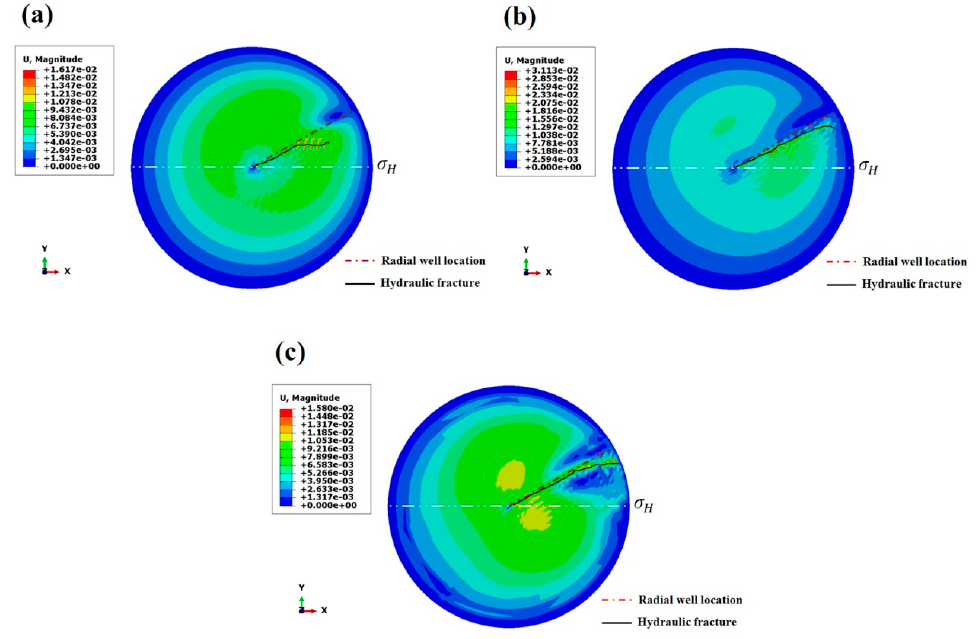
Figure 8. Simulation results of hydraulic fracture propagation guided by a single radial well under radial well different diameters: ( a ) Φ = 0.03 m; ( b ) Φ = 0.05 m; and ( c ) Φ = 0.07 m.